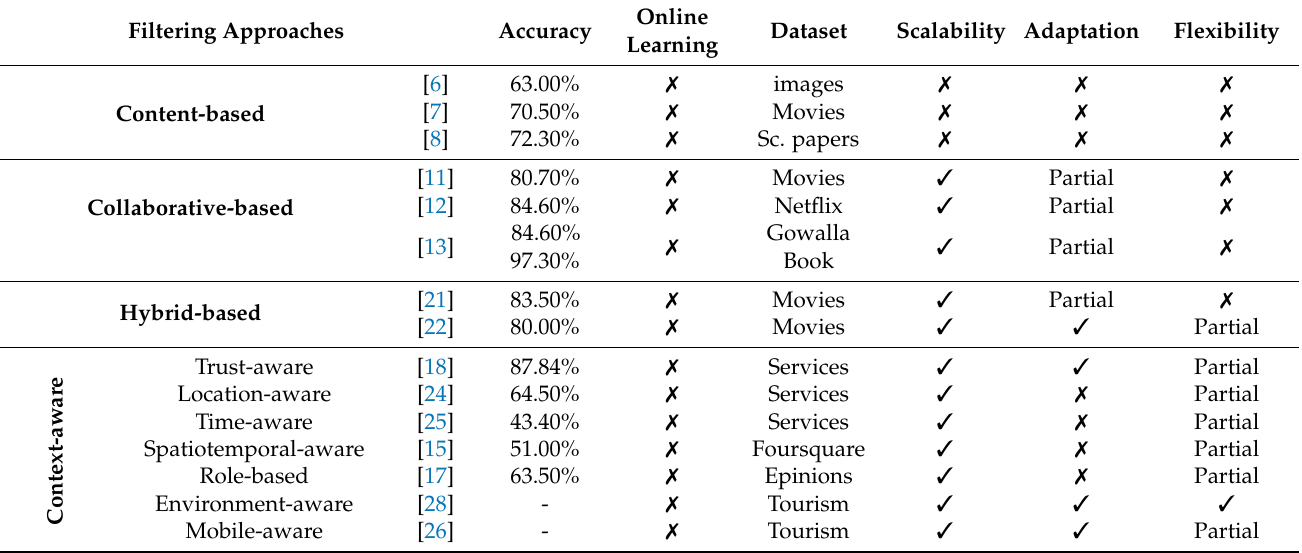
Table 1. Comparison of recommendation